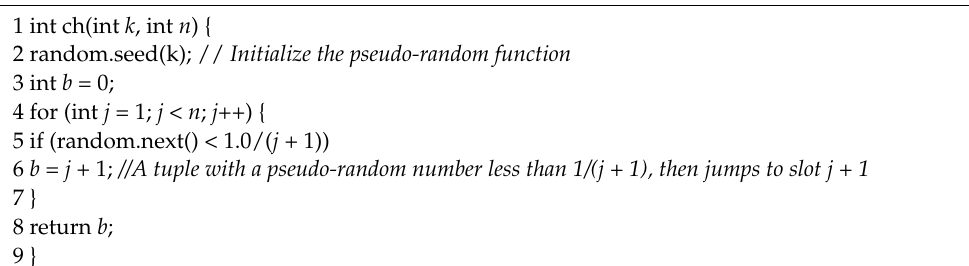
Algorithm 1: Jump Consistent Hash Algorithm